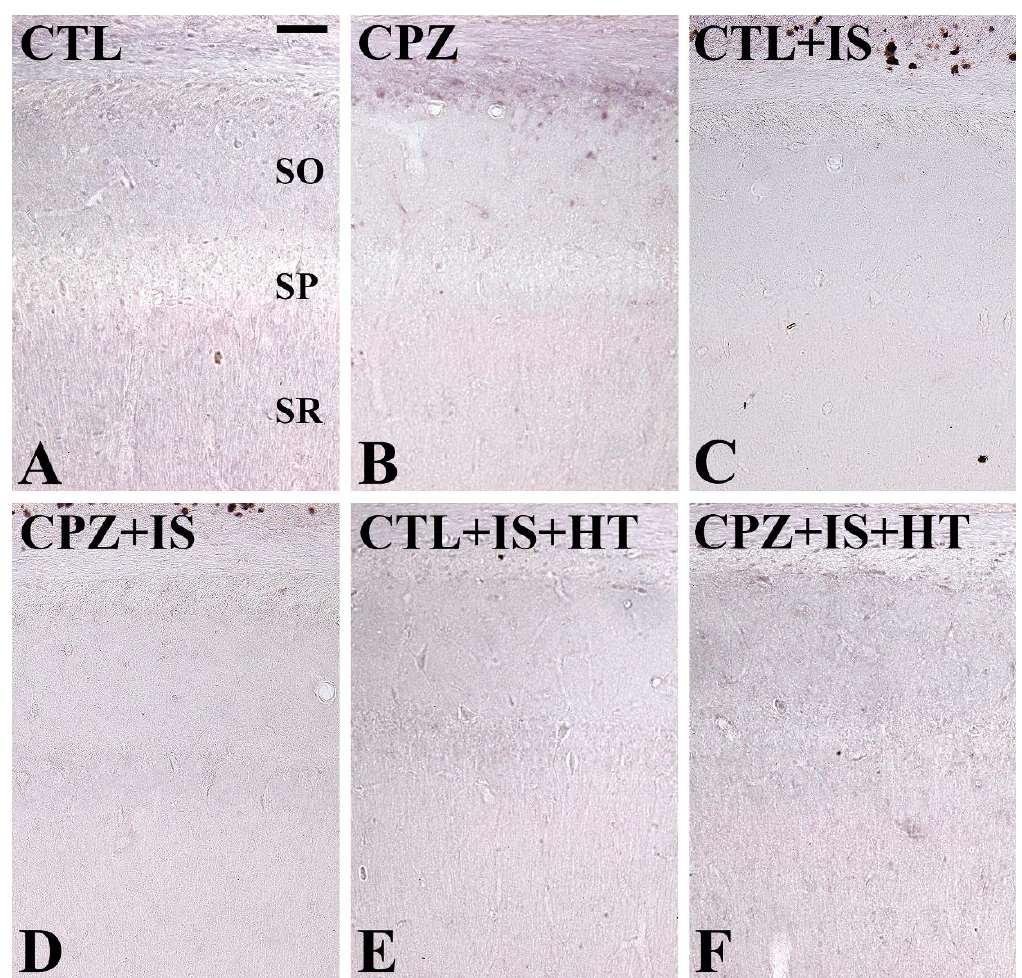
Figure 6. Mac3 immunohistochemistry in the gerbil hippocampal CA1 region of the CTL ( A ), CPZ ( B ), CTL + IS ( C ), CPZ + IS ( D ), CTL + IS + HT ( E ), and CPZ + IS + HT ( F ) groups. Mac3-immunoreactive macrophages were not detectable in the hippocampal CA1 region of all groups.